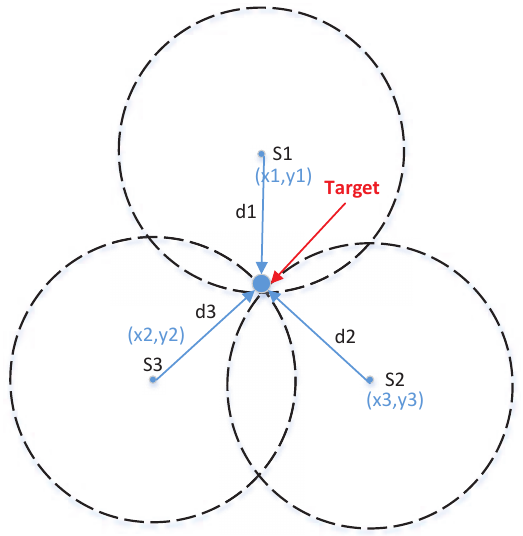
Figure 5. Description of the trilateration